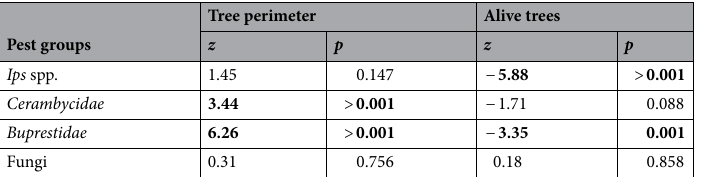
Table 3. The effect of the tree characteristics (tree perimeter and proportion of alive trees) on the different pest groups ( Ips and fungi). The results are based on the GLMM models (binomial error, maximum-likelihood fit). *Significant results are with bold